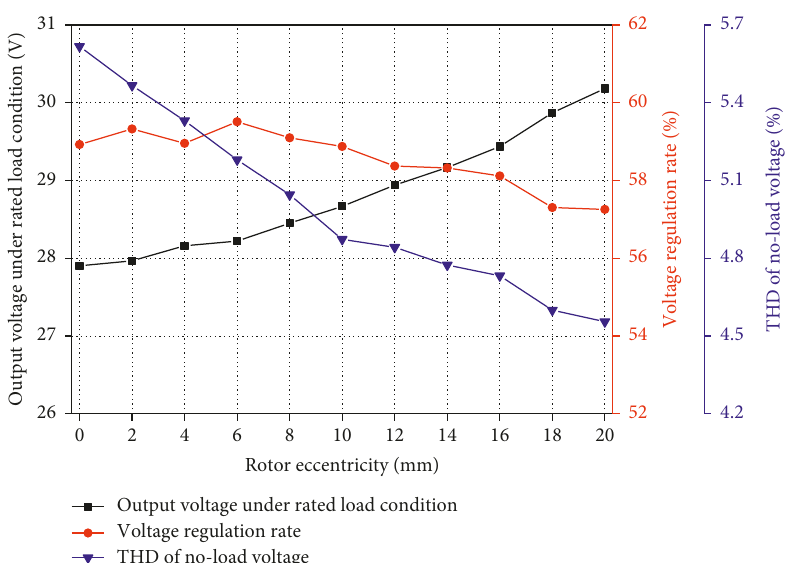
Figure 14: Variation curves of generator output performance with different rotor eccentricities.